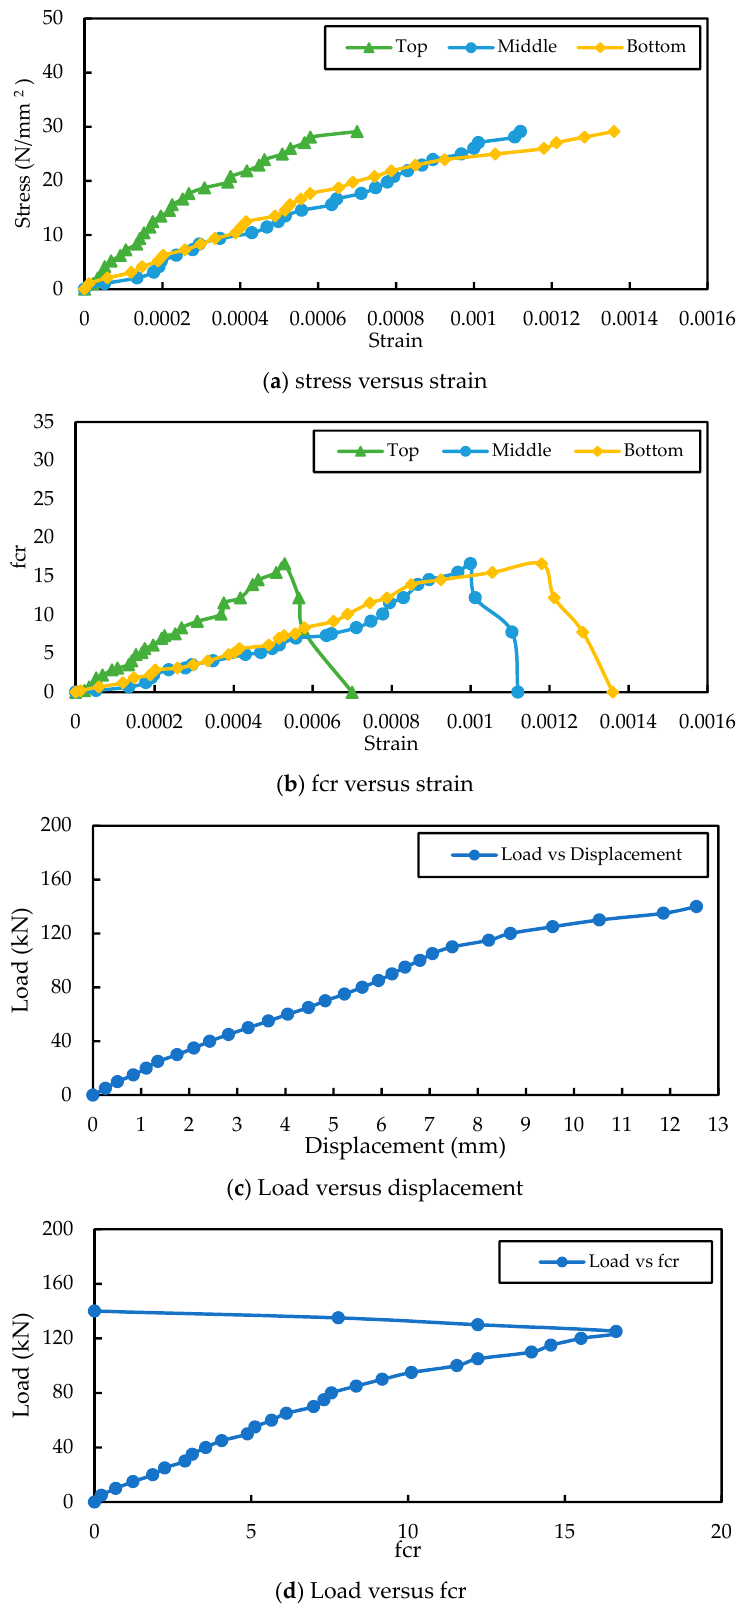
Figure 10. Graphical representation of ( a ) stress vs. strain, ( b ) fcr vs. strain, ( c ) load vs. displacement, and ( d ) load versus fcr behaviour of hybrid brass carbon fibre added fresh mortar layer cast on a fresh concrete beam of length 1.5 m.